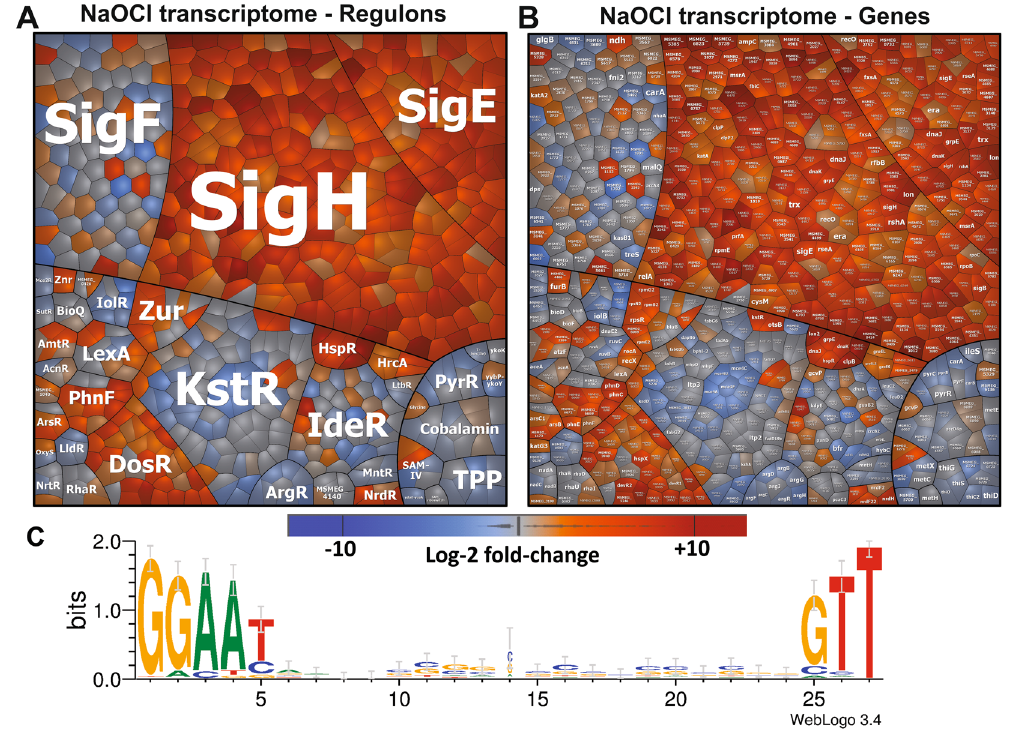
Figure 8. The transcriptome treemap indicates the strong induction of the SigH and SigE oxidative stress regulons under NaOCl stress in M. smegmatis. ( A , B ) The transcriptome treemap shows changes in gene expression of the M . smegmatis wild type under 1 mM NaOCl stress as log2-fold changes (m-values). The genes are classified into operons and regulons based on the RegPrecise database (http://regprecise.lbl.gov/RegPrecise/ index.jsp) and the newly defined SigH and SigE regulons of this work. The regulon classification is used as legend ( A ) for the gene expression treemap in ( B ). Differential gene expression is visualized using an orange- blue color code where orange indicates log2-fold induction and blue repression of transcription under NaOCl stress. The oxidative stress-specific SigH and SigE-regulons are most strongly up-regulated under NaOCl stress. The Web-logo of the SigH-promoter consensus sequence ( C ) was created using WebLogo 3.0 78 based on the alignment of 124 SigH-promoters identified in this